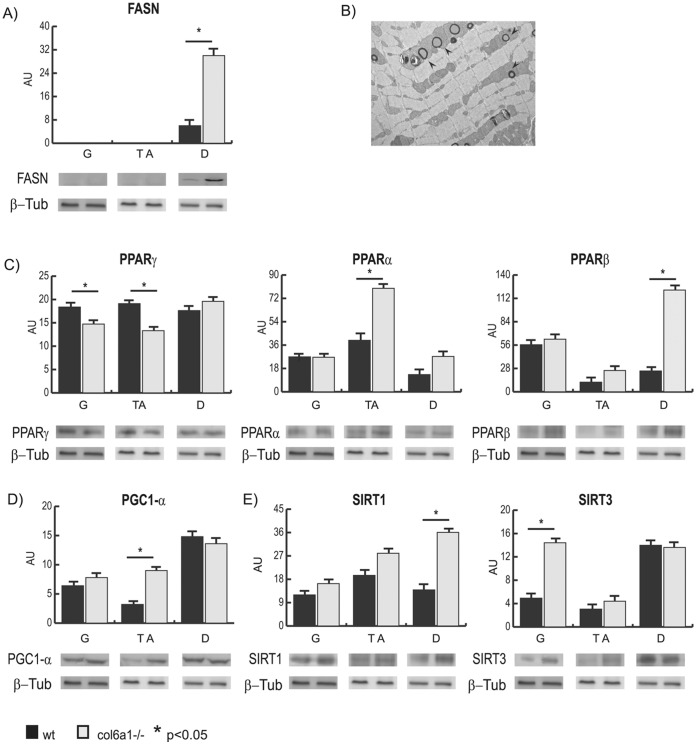
Immunoblotting of proteins involved in lipid metabolism.Histograms and representative immunoblot images of FASN (panel A), PPARγ, α and β (panel C), PGC1-α (panel D), SIRT1 and SIRT3 (panel E) in gastrocnemius, tibialis anterior and diaphragm from Col6a1
−/− and wild-type mice (n = 4; mean ± S.D.; Student’s T-test). Panel B: electron microscopy image showing lipid accumulation in the diaphragm of Col6a1
−/− mice. Black arrows show lipid droplets.